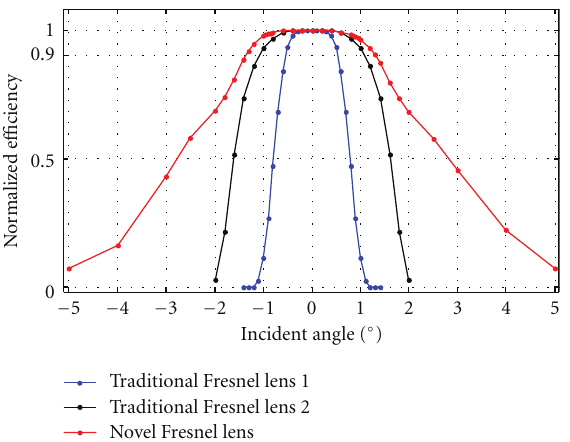
Figure 8: Relative transmission curve versus incident angle. The traditional Fresnel lens 1 and 2 represent the Fresnel concentrator without secondary lens and with secondary lens, respectively.